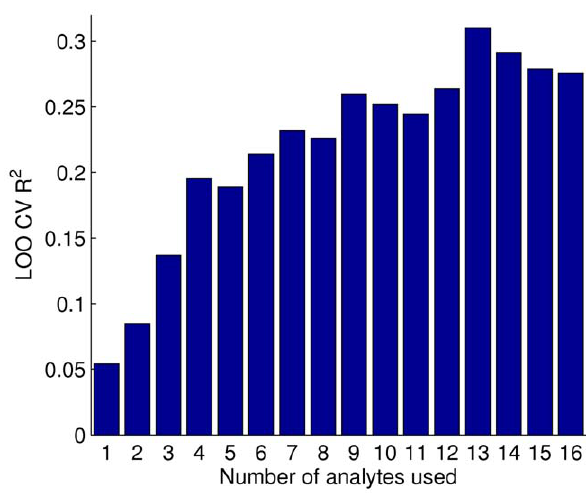
Figure 2. Cross validation of multiple linear regression. Barplot of the LOO CV R 2 of multiple linear regressions of brain amyloid burden against a range of RBM analytes and co-variates. Subsets of RBM analytes that associated with brain amyloid levels with a p-value v 0.05 were used. Various subsets were chosen by hierarchical clustering at various cutoffs, with the analyte most associated with brain amyloid burden in each cluster chosen to represent that cluster. Age, gender, years of education, the number of APOE E 4 alleles and the difference, in days, between plasma sampling and [ 11 C]-PiB PET scan were used as co- variates.